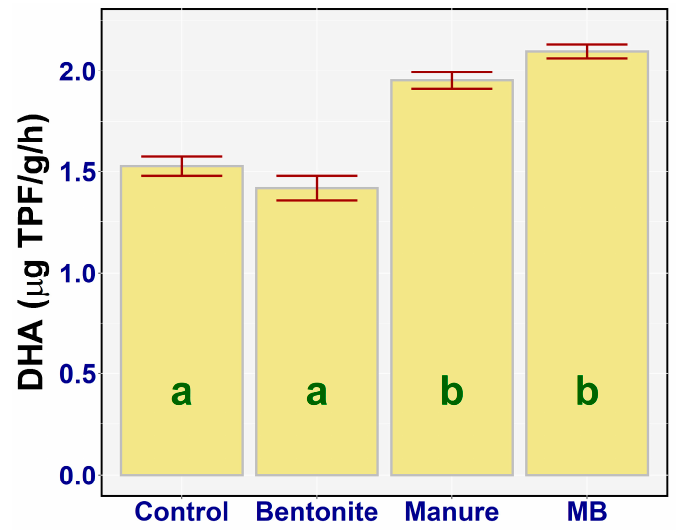
Figure 4. Dehydrogenase activity (DHA) activity of the treatments: means with SEM (standard error of mean).